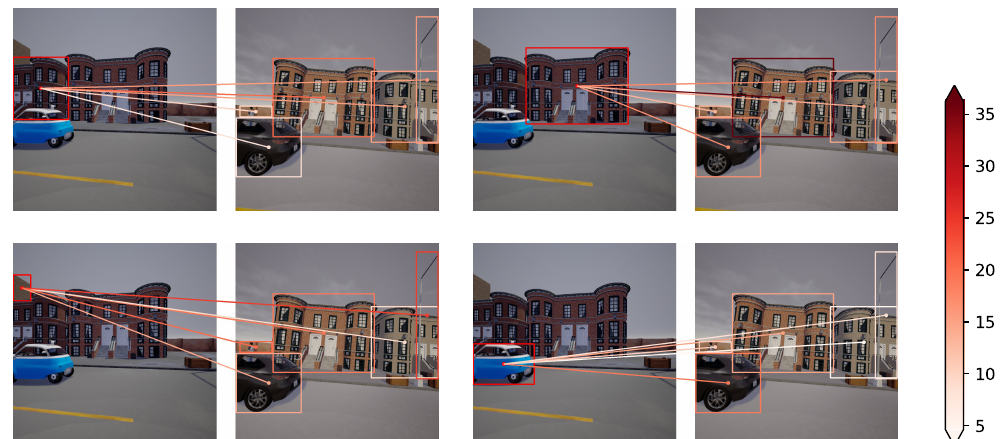
Figure 2. A visualization of the affinity scores between the objects in I 1 and I 2 . The lines connecting the centers of the boxes represent the s ij (as described in Section 3.3). The figure demonstrates that objects with similar appearances had high affinity scores. For example, in the second image in the first row, the object that is enclosed by the box in I 1 and the building in the center of I 2 had higher scores.